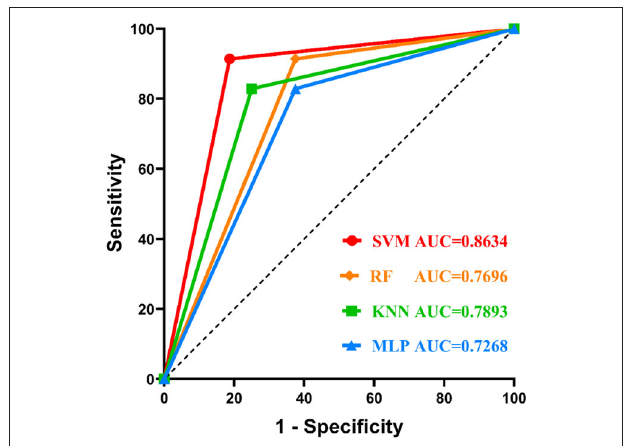
FIGURE 6 | Comparison of the ROC curves of different ML classifiers. The SVM classifier performs